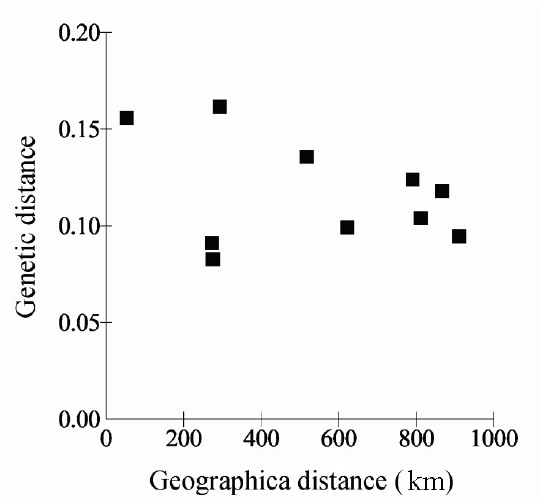
Figure 1. Relationship between genetic and geographic distance of the C. japonicum populations.